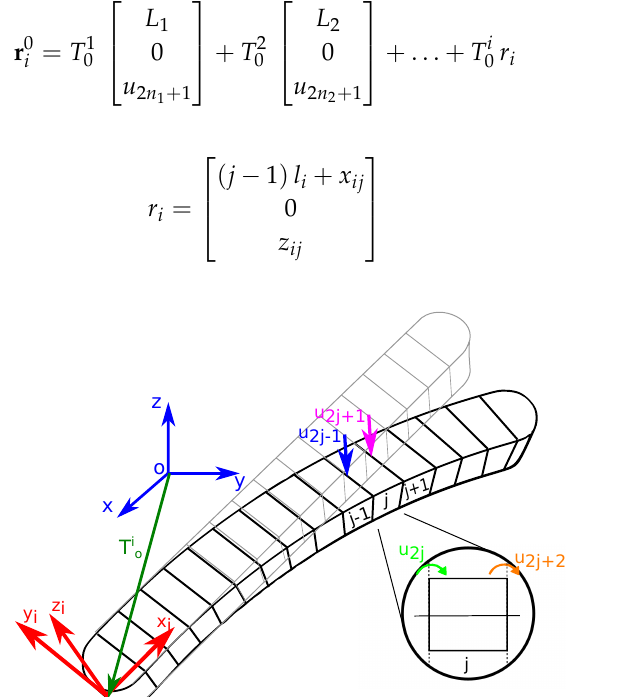
Figure 3. Schematics of the DOF of each link’s